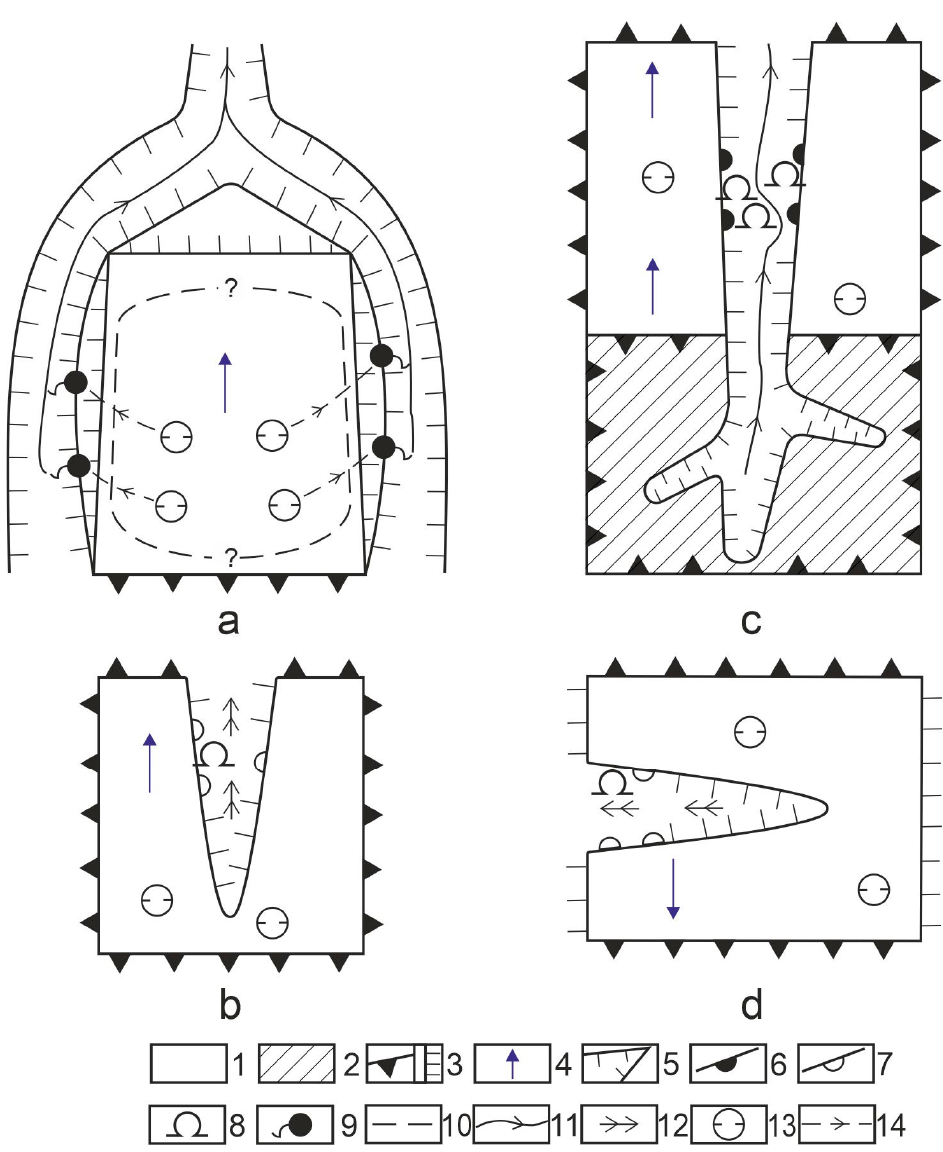
Figure 8. Closed epigene karst system ( a ), mixed epigene karst system ( b ), incomplete epigene karst system at valley coinciding with block inclination ( c ) and incomplete epigene karst system in the case of valley situated anti-dip of block ( d ), in plan view. Legend: 1. Limestone covered with soil and permeable cover, 2. Block covered with aquifuge, 3. Fault scarp of block, 4. Dip direction of block surface, 5. Epigenetic valley, 6. Epigenetic-antecedent gorge, 7. Other valley section with gorges, 8. Cave-ins, 9. Spring, 10. Approximate boundary of perched water table, 11. Stream, 12. Intermittent stream, 13. Suffosion doline, 14. Water flow in the karst.